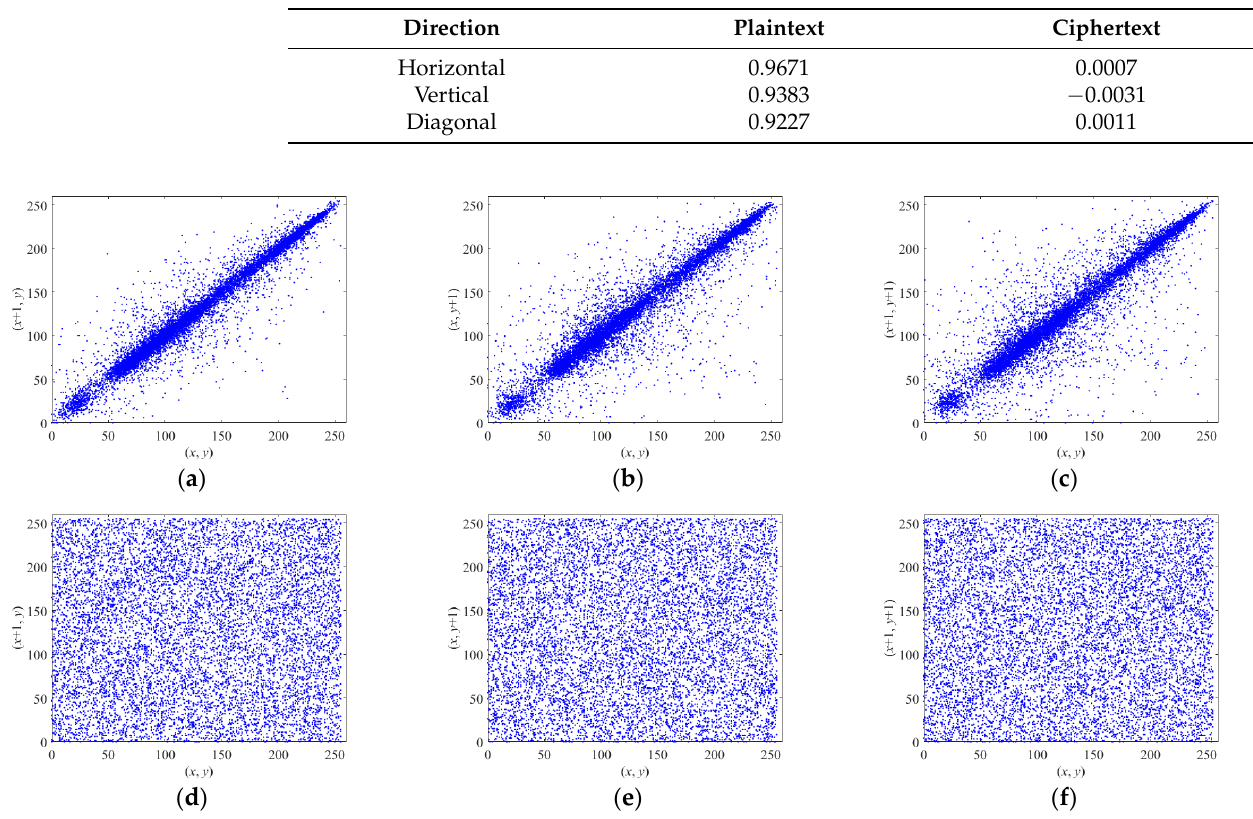
Figure 12. Distribution of pixels, ( a ) Horizontal direction of the plaintext, ( b ) Vertical direction of the plaintext, ( c ) Diagonal direction of the plaintext, ( d ) Horizontal direction of the ciphertext, ( e ) Vertical direction of the ciphertext, ( f ) Diagonal direction of the ciphertext.